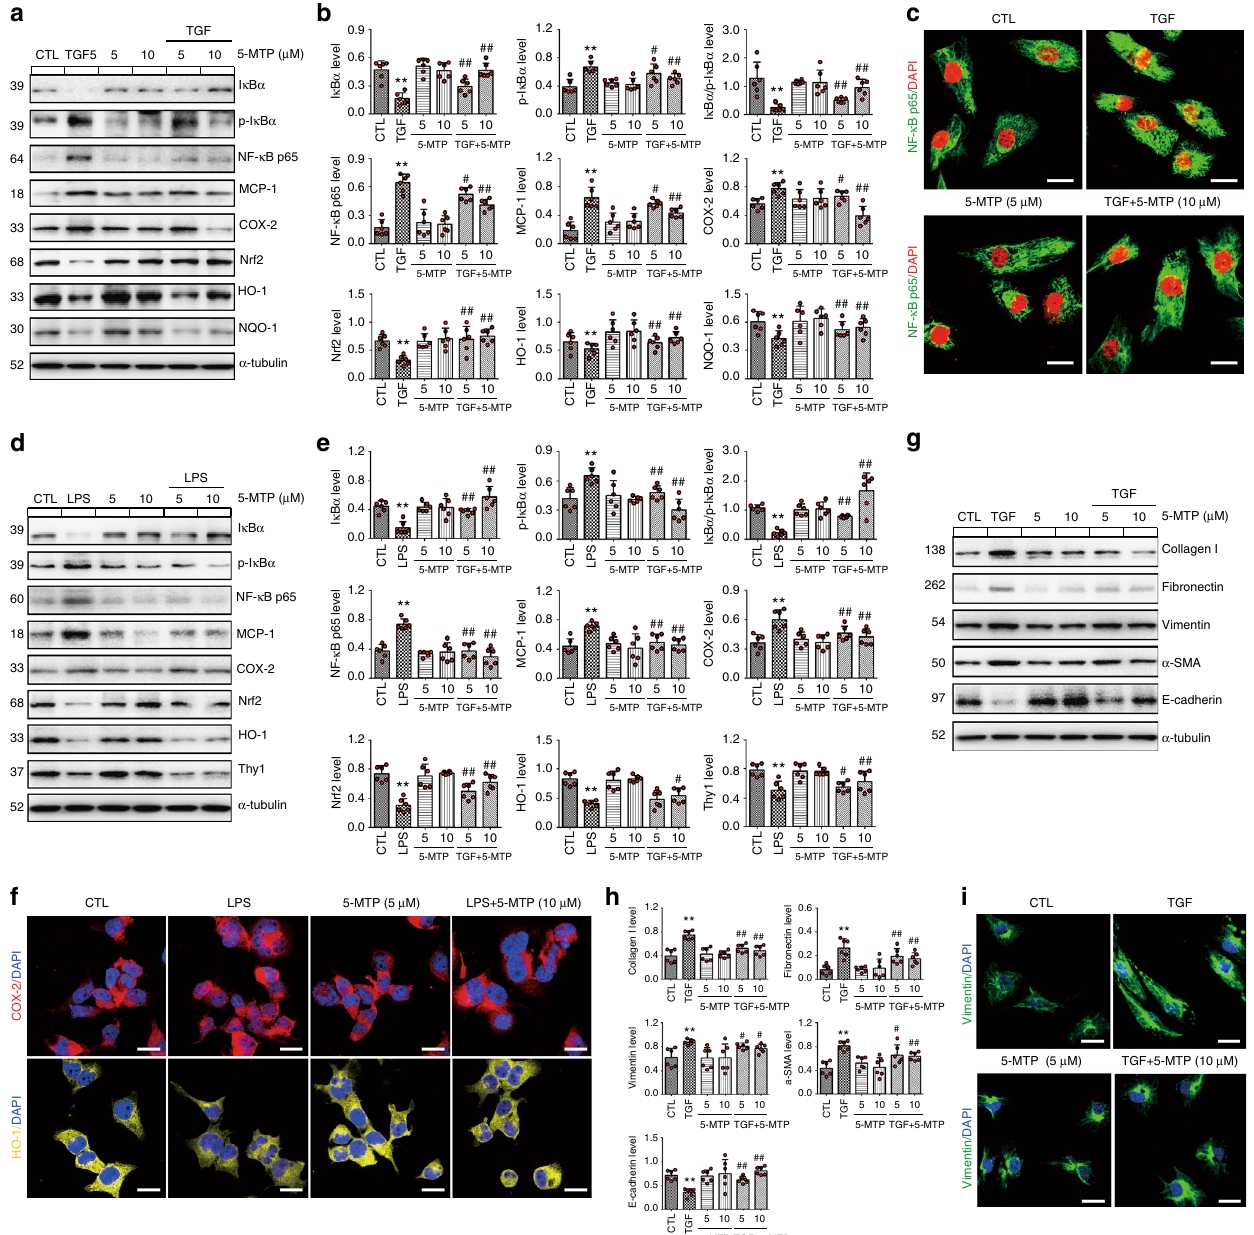
Fig. 7 The anti-in fl ammatory and anti- fi brotic effects of 5-MTP in vitro. a , b The protein expression and relative quantitative data of I κ B α , p-I κ B α , NF- κ B p65, COX-2 and MCP-1 as well as Nrf2, HO-1 and NQO-1 in HK-2 cells induced by TGF- β 1 as indicated. * P < 0.05, ** P < 0.01 compared with CTL group ( n = 6). # P < 0.05, ## P < 0.01 compared with TGF- β 1-induced group ( n = 6). c Representative immuno fl uorescent staining of NF- κ B p65 in HK-2 cells induced by TGF- β 1 as indicated. Scale bar, 25 μ m. d , e The protein expression and relative quantitative data of I κ B α , p-I κ B α , NF- κ B p65, COX-2 and MCP-1 as well as Nrf2, HO-1 and NQO-1 in HMC induced by LPS as indicated. * P < 0.05, ** P < 0.01 compared with CTL group ( n = 6). # P < 0.05, ## P < 0.01 compared with LPS-induced group ( n = 6). f Representative immuno fl uorescent stainings of COX-2 and HO-1 in HMC induced by LPS as indicated. Scale bar, 25 μ m. g , h The protein expression and relative quantitative data of collagen I, fi bronectin, α -SMA and E-cadherin in HK-2 cells induced by TGF- β 1 as indicated. * P < 0.05, ** P < 0.01 compared with CTL group ( n = 6). # P < 0.05, ## P < 0.01 compared with TGF- β 1-induced group ( n = 6). i Representative immuno fl uorescent staining of vimentin in HK-2 cells induced by TGF- β 1 as indicated. Scale bar, 25 μ m. CTL, control; LPS, lipopolysaccharide; TGF, transforming growth factor- β 1. Dot presents the single data result in bar graph. Data are presented as means ± SD. One-way ANOVA followed by Dunnett ’ s post hoc test for multiple comparisons was used for three or more